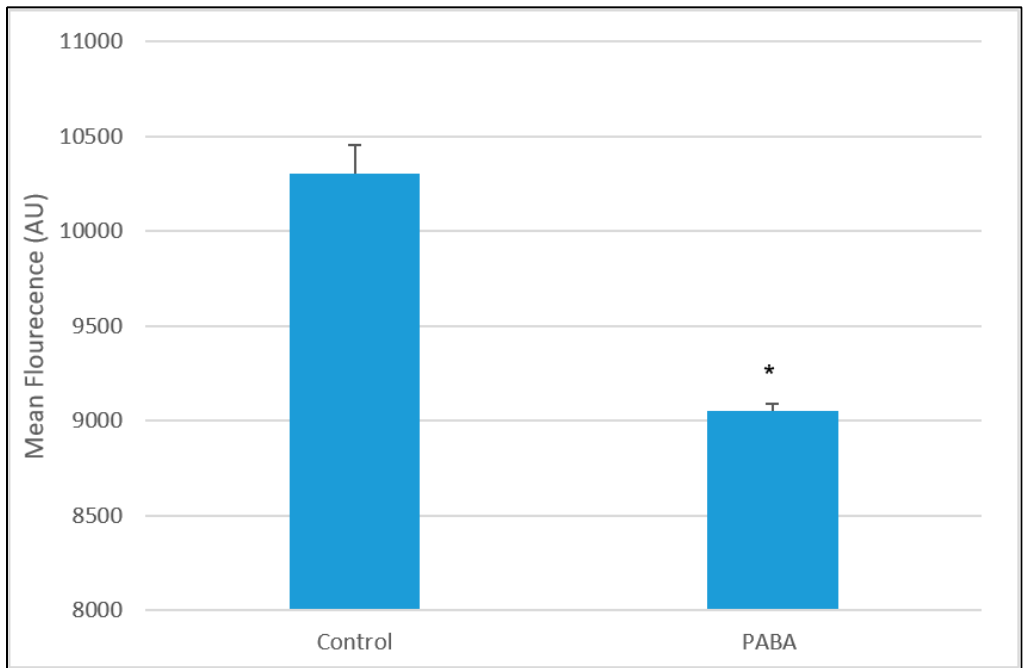
Figure 6. Mean LysoSensor fluorescence for PABA-treated cells vs. controls. Data available in supplemental data under Table S6. Significance levels * p < 0.05; n = 94.